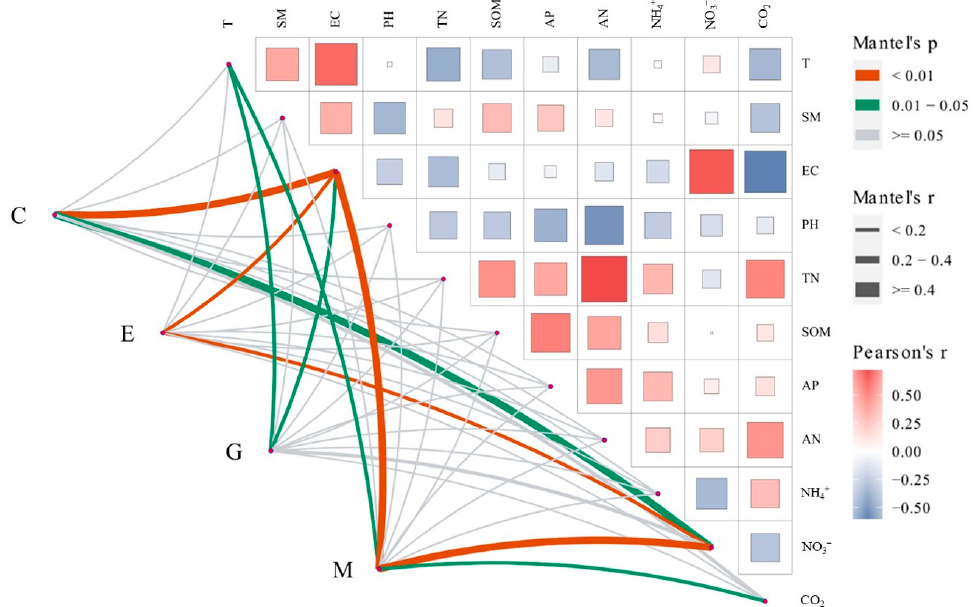
Figure 2. Correlation between 1-level functional prediction classification and environmental factors of soil bacteria in the Yellow River Delta; M: metabolism; G: genetic information processing. E: environmental information processing; C: cellular processes. Notes: The correlation coefficients between environmental factors are represented by the area of the square, the larger the area, the larger the correlation coefficient, blue indicates a positive correlation, red indicates a negative correlation, and the degree of correlation between bacterial function and environmental factors is represented by the width of the line, Different line widths indicate different R-values after the mantel test , the wider the line the stronger the correlation.